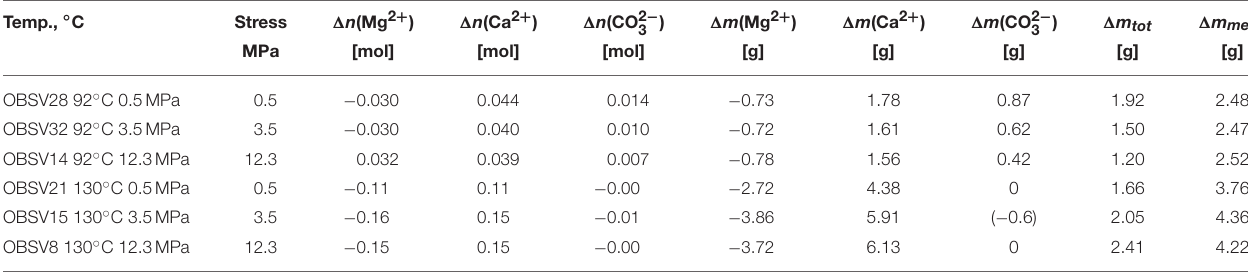
TABLE 6 | Integrated effluent Ca 2 + and Mg 2 + concentrations. Temp., ◦ C